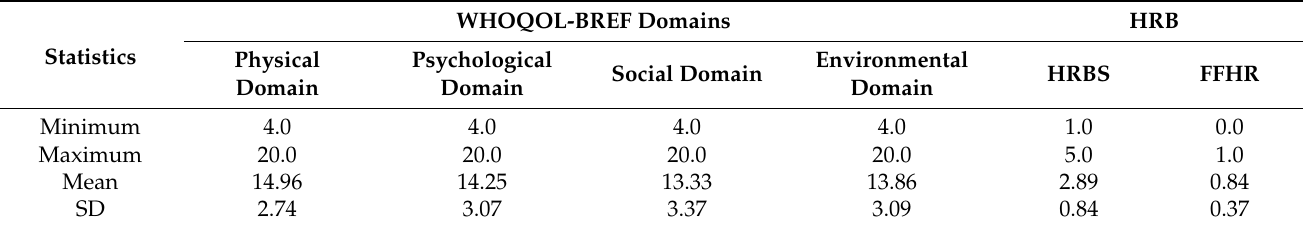
Table 2. Scores of four major WHOQOL-BREF domains and HRB.